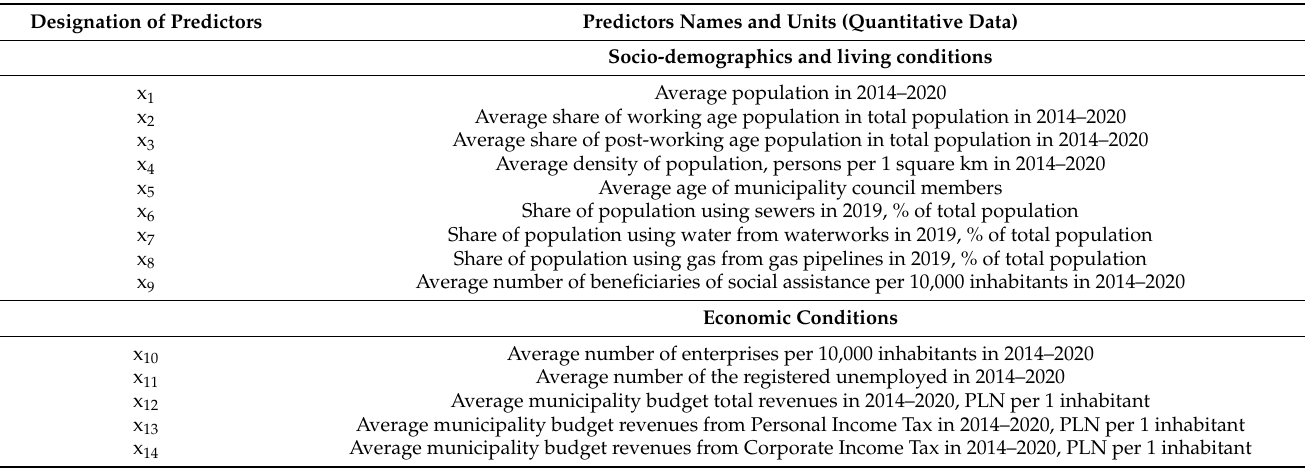
Table 3. Definitions of predictors used in multiple linear